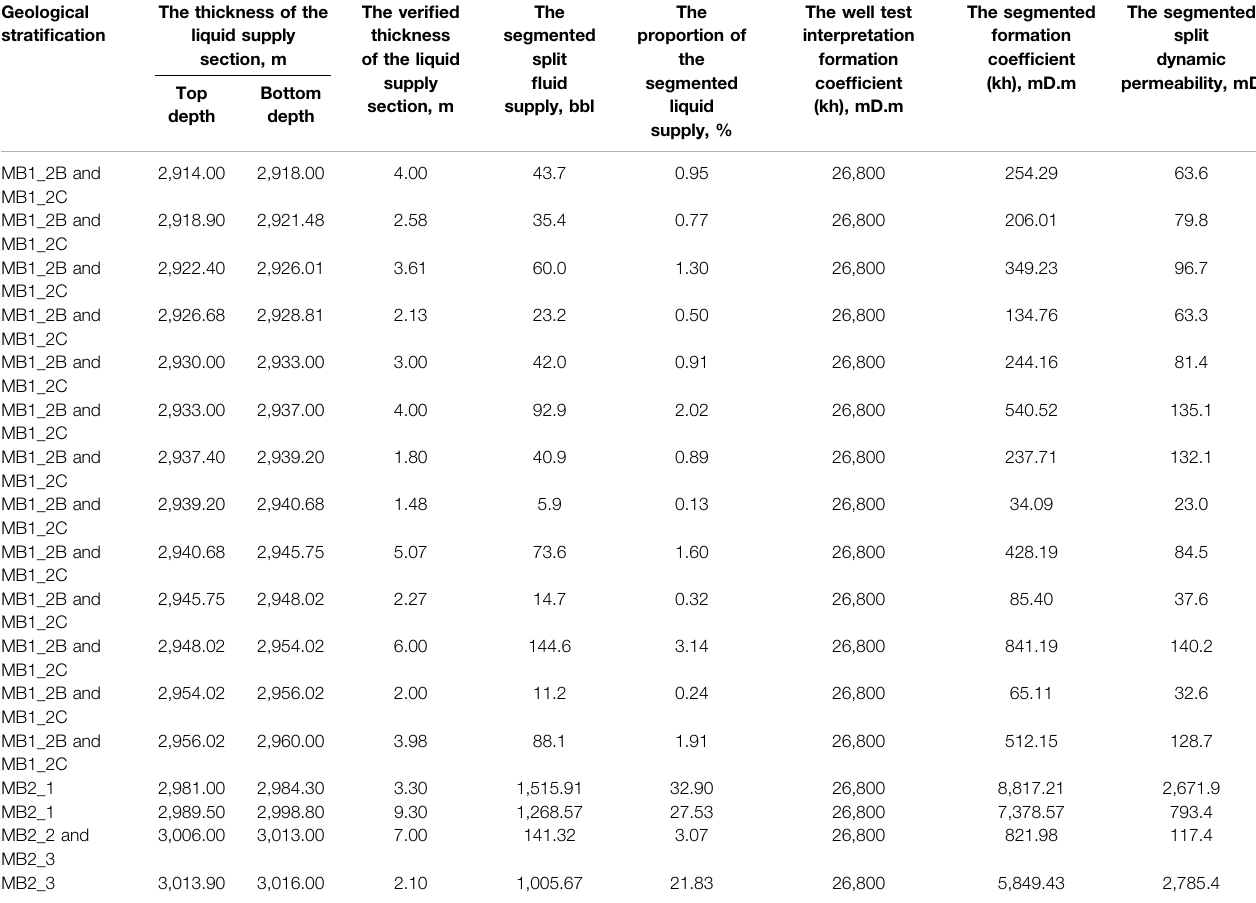
TABLE 4 | Summary of sectional dynamic permeability calculation of P1. Geological strati fi